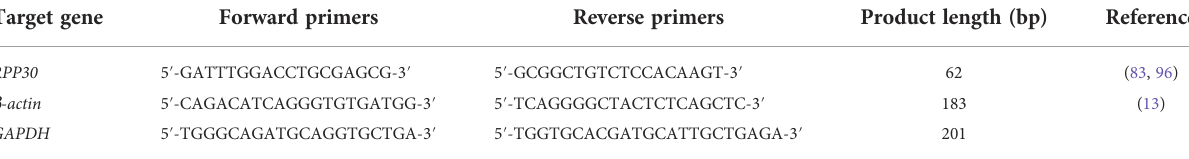
TABLE 2 Internal reference gene primer sequences.